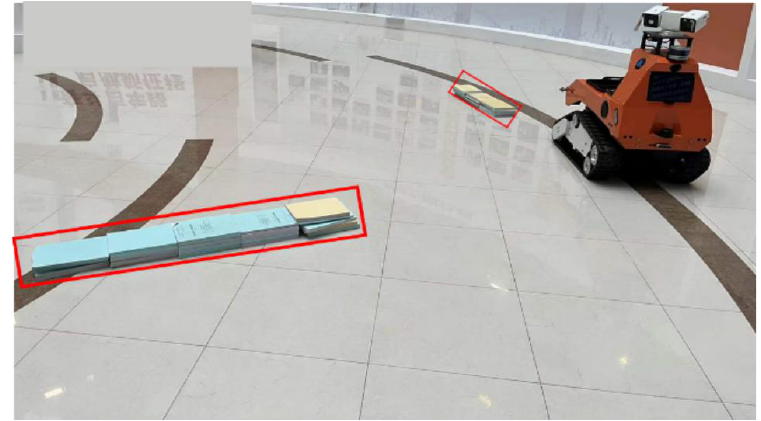
Figure 12. Obstacle scene. Table 2. Comparison of mapping speed.